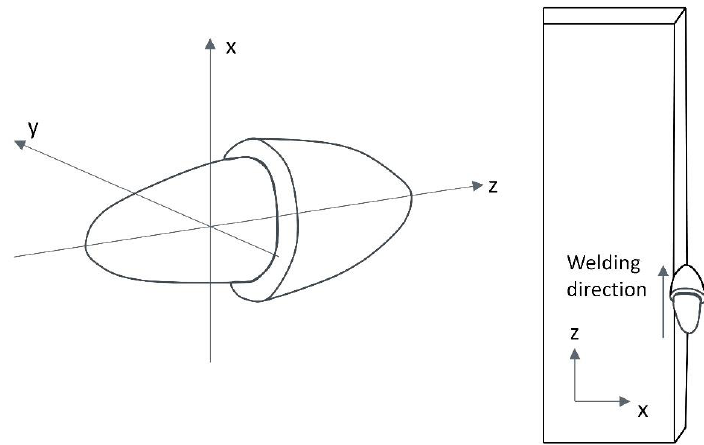
Figure 5. Schematic diagram of heat source (semi-ellipsoid heat source).